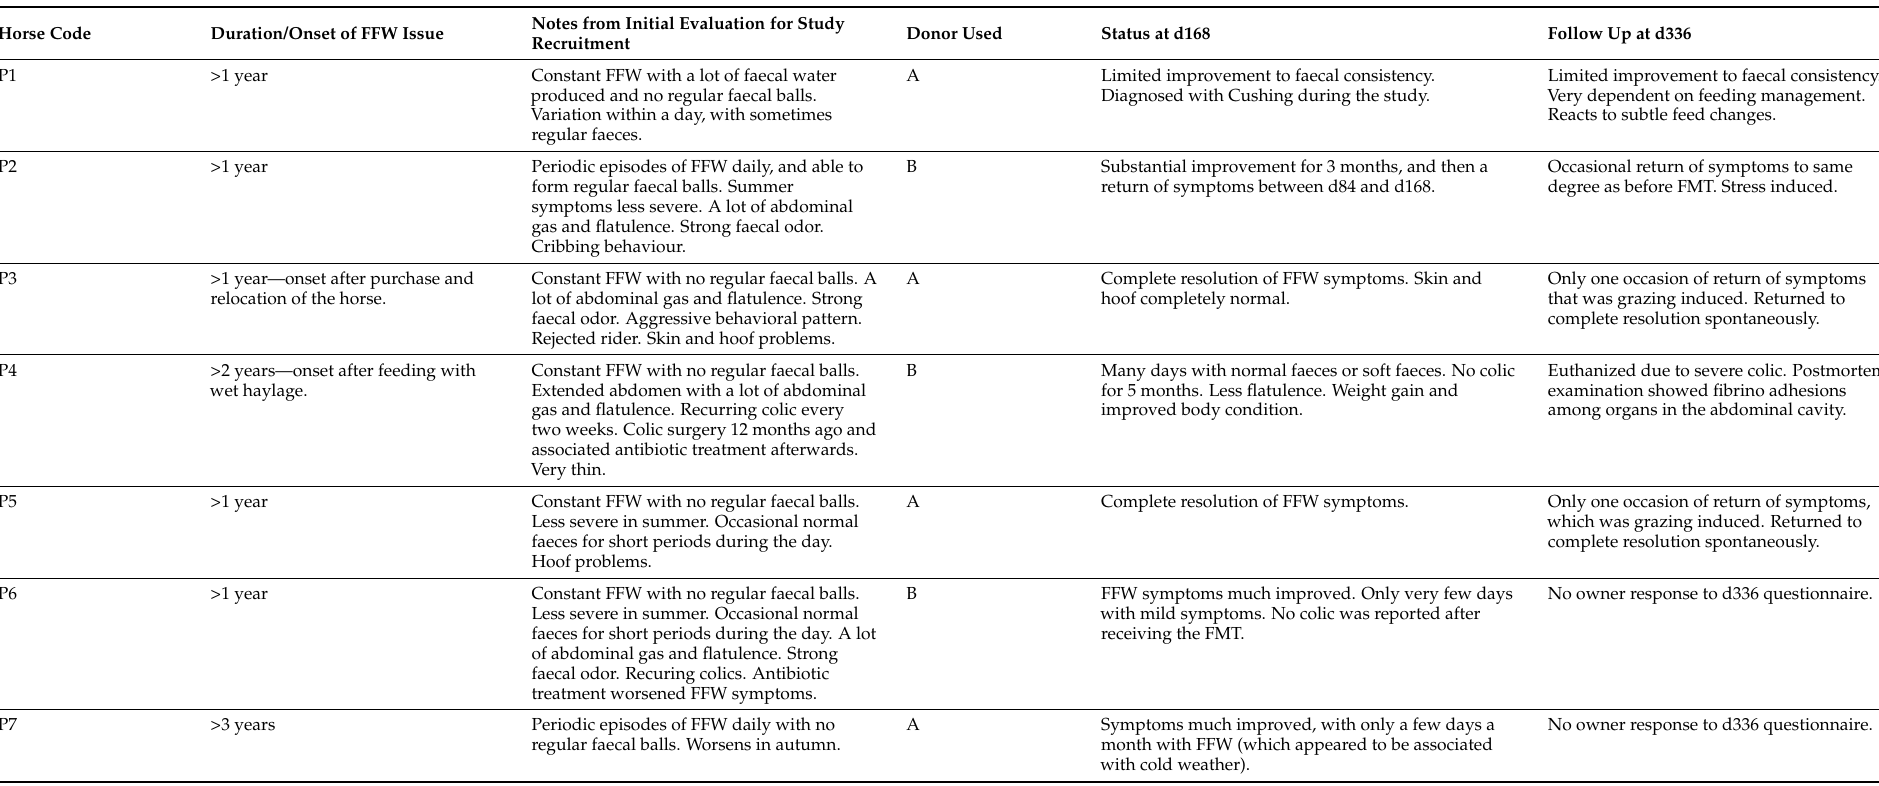
Table 2. Details of the free faecal water (FFW) horses + in terms of the duration/onset of the issue, initial evaluation notes, donor animal used and the outcome of the faecal microbial transplant (FMT)